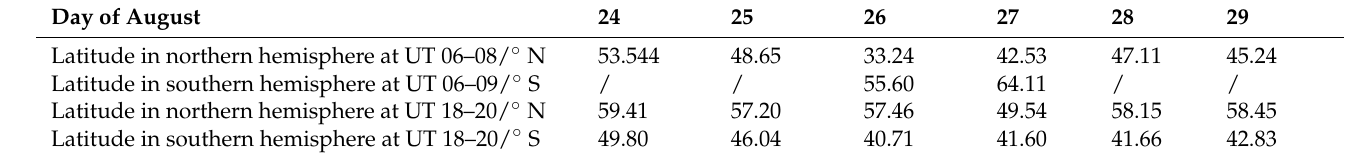
Table 1. The first minimum position of midlatitude trough of Ne from CSES during 24 and 29 August.